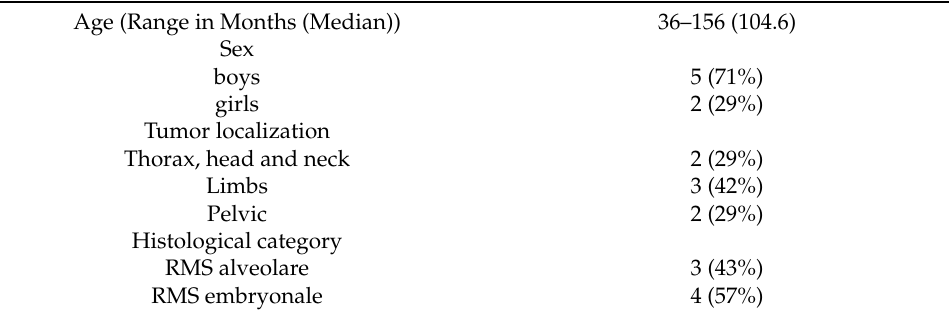
Table 3. Patho-clinical characteristics of